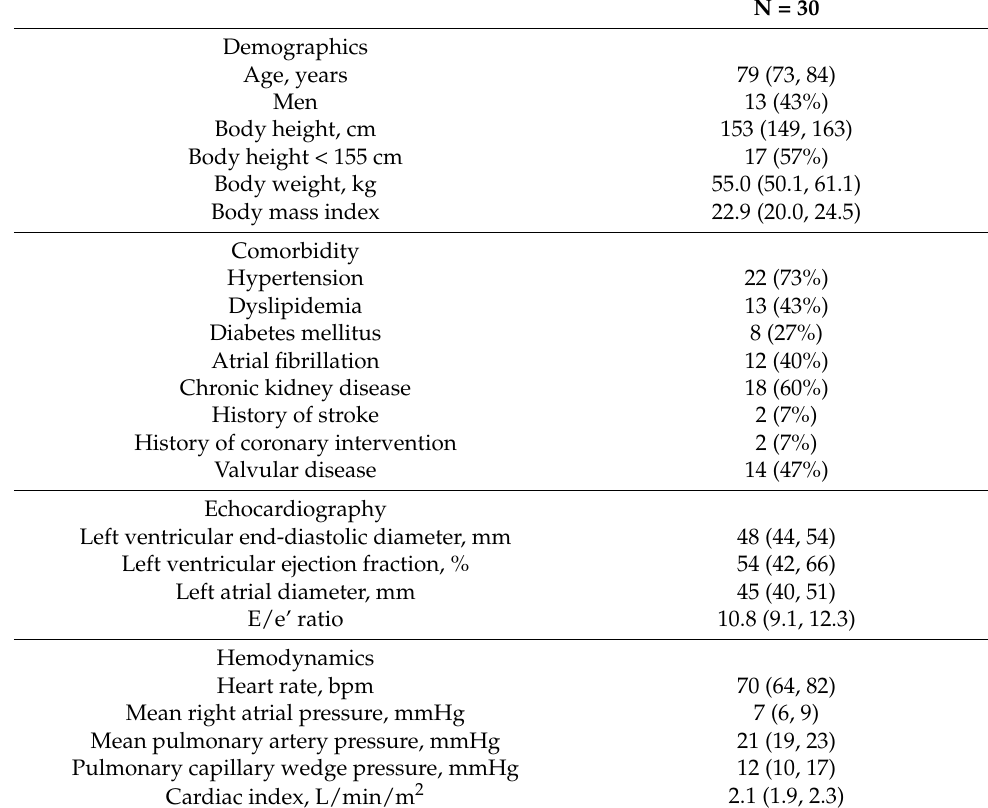
Table 1. Baseline